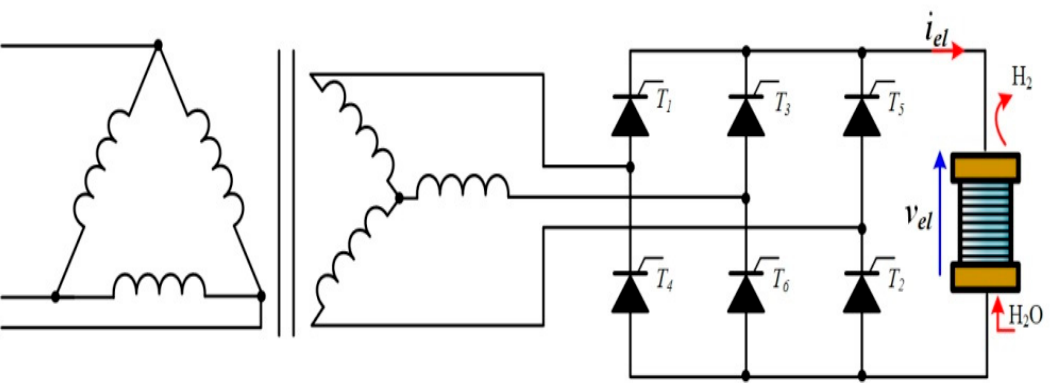
Figure 8. Six-pulse thyristor bridge rectifier.